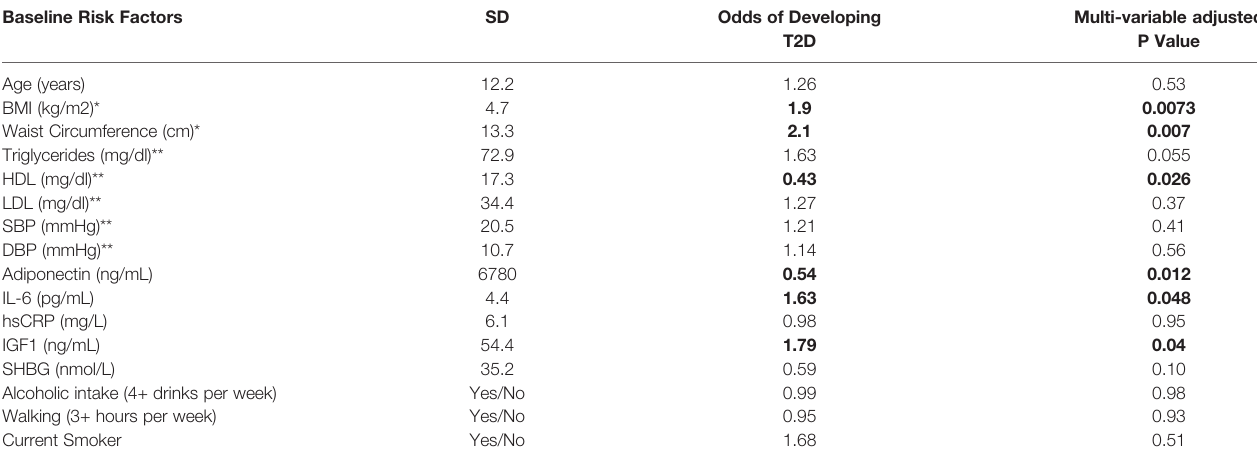
TABLE 3 | Risk factors for incident T2D in LLFS spousal controls +